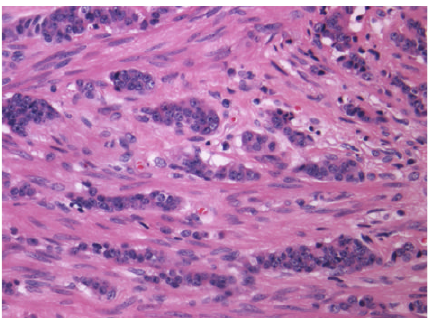
Figure 3: Well-differentiated endocrine tumour (classic carcinoid) H&E × 200 Nests and cords of uniform, bland, cohesive tumour cells with round nuclei, stippled chromatin, and eosinophilic